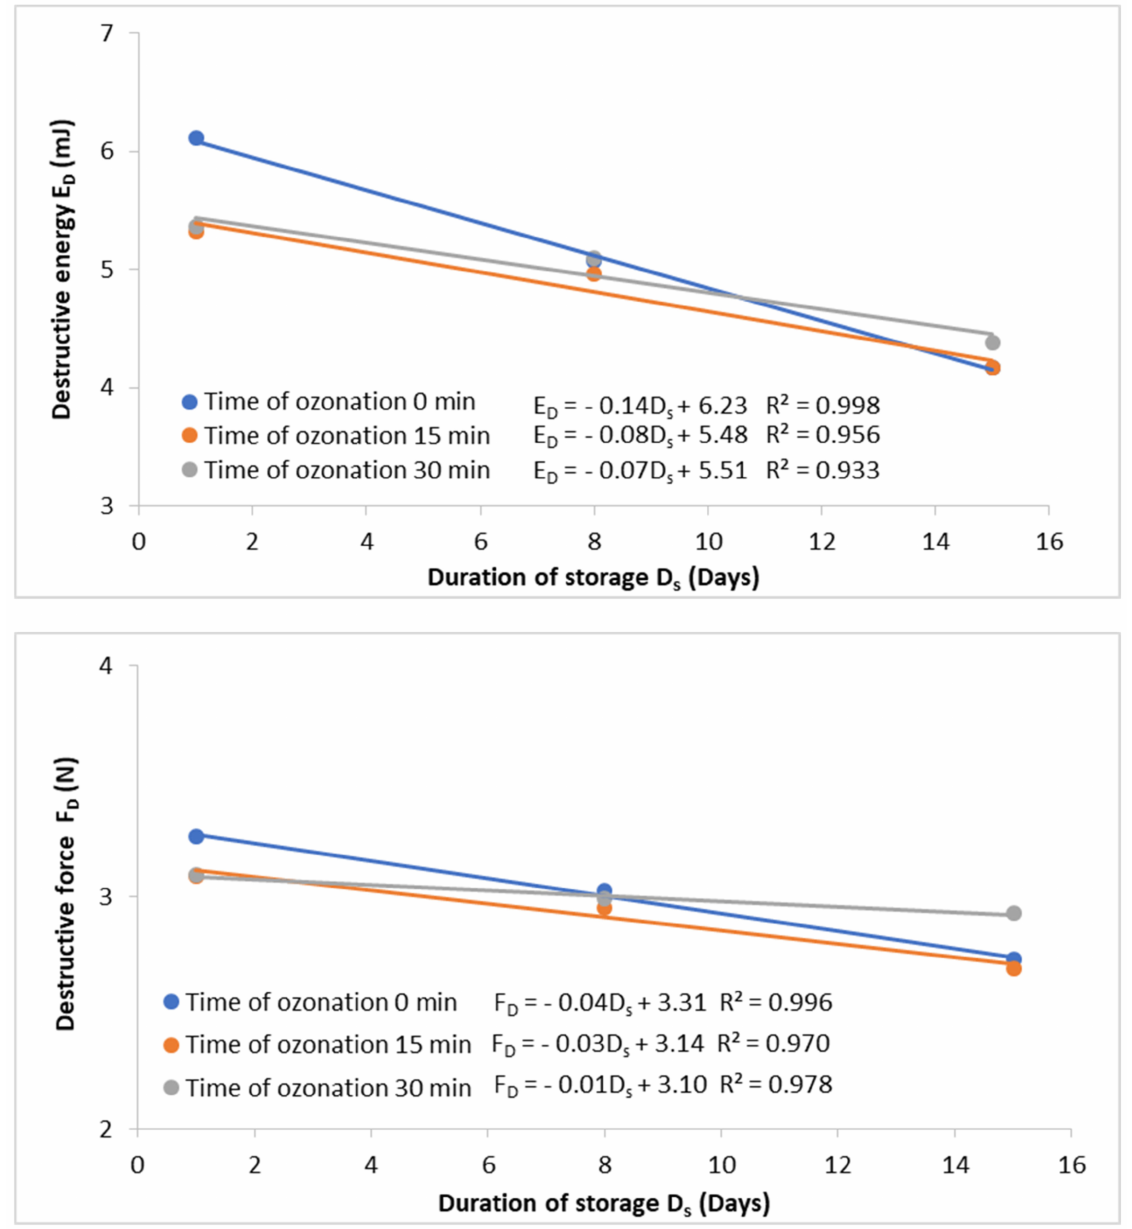
Figure 1. The dependence of the destructive force and energy, as well as the apparent modulus of elasticity, on the storage time of red currant fruit for three varieties and the ozonation